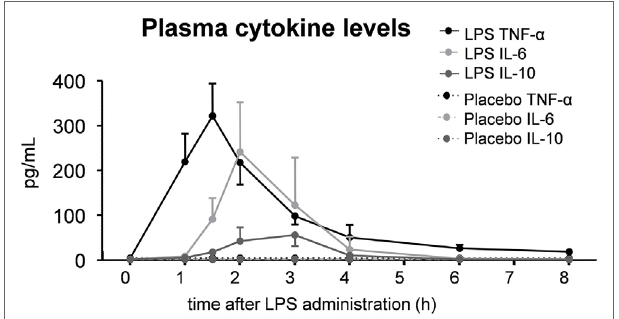
FigUre 3 | Plasma levels of the cytokines TNF- α , IL-6, and IL-10 in 30 subjects who received an intravenous administration of lipopolysaccharide (LPS) ( n = 15) or placebo ( n = 15) at T = 0. Data are represented as median